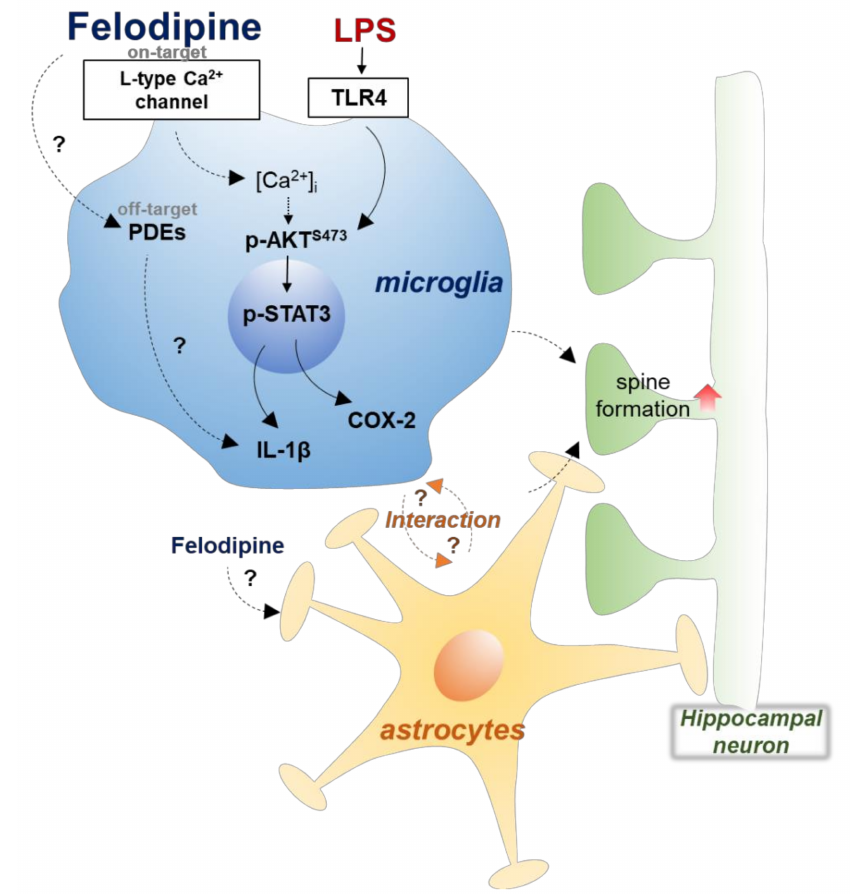
Figure 9. Schematic diagram of the effects of felodipine on LPS-induced neuroinflammatory responses and cognitive function. In microglial cells, felodipine downregulates LPS-induced proinflammatory cytokine COX-2 and IL-1 β levels through L-type Ca 2+ channel/TLR4/AKT signaling. Felodipine also inhibits LPS-stimulated nuclear STAT3 phosphorylation in microglia. In C57BL/6 (wild-type) mice, felodipine reduces LPS-induced micro/astrogliosis and proinflammatory cytokine COX-2 and IL-1 β levels and reduces the short-term spatial memory impairment, decrease in hippocampal dendritic spinogenesis, and increase in microgliosis induced by chronic LPS administration. The capacity of felodipine to alter LPS-induced gliosis in vitro/in vivo and to modulate neuroinflammation-linked be- havior suggests that felodipine may have potential for the treatment of neuroinflammation/cognitive function-linked